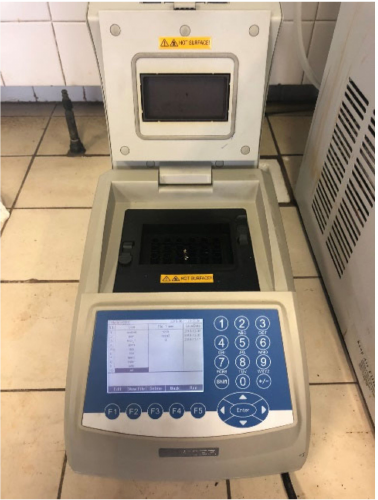
Figure 16. Picture of stability testing device “UDL-GREiA